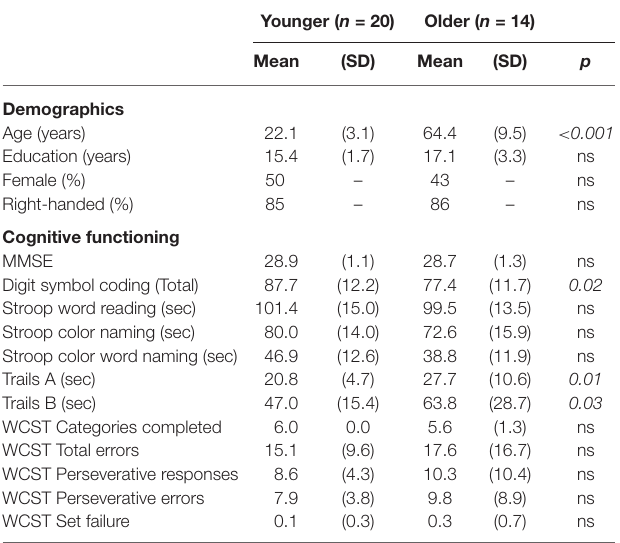
TABLE 1 | Demographic and cognitive data for younger and older participants.